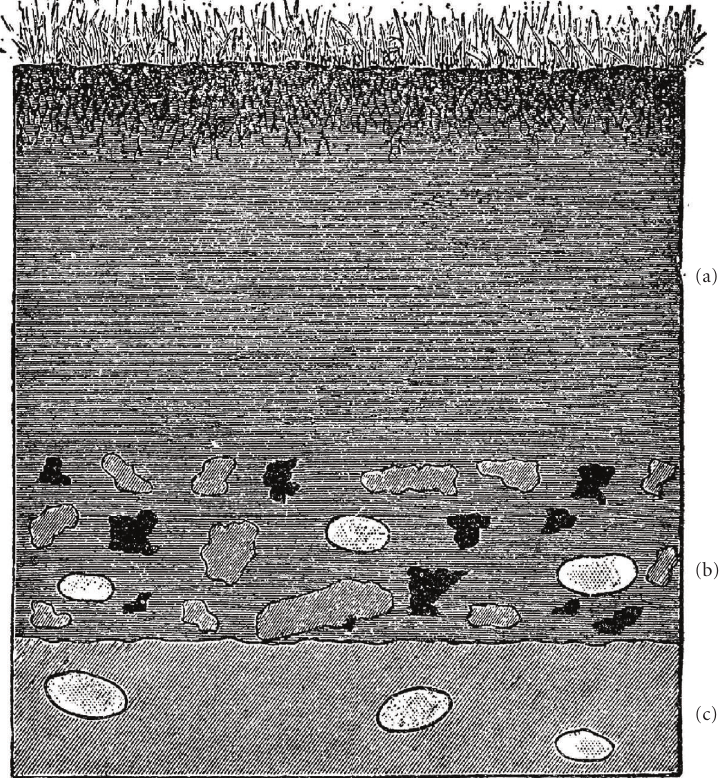
Figure 3: Cross section of the vegetable mould in a field, drained and reclaimed fifteen years previously. (a) Vegetable mould, without stones, (b) Mould with fragments of burnt marl, coal-cinders and quartz pebbles, (c) Subsoil of black, peaty sand with quartz pebbles (adapted from Darwin 1881